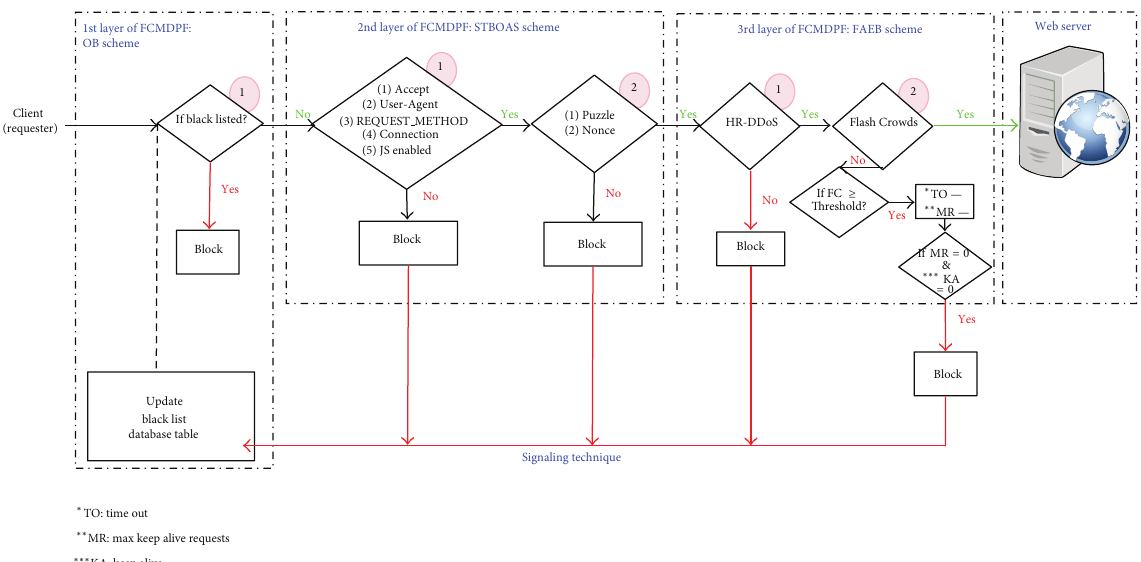
Figure 1: Components of flexible collaborative multilayer DDoS prevention framework